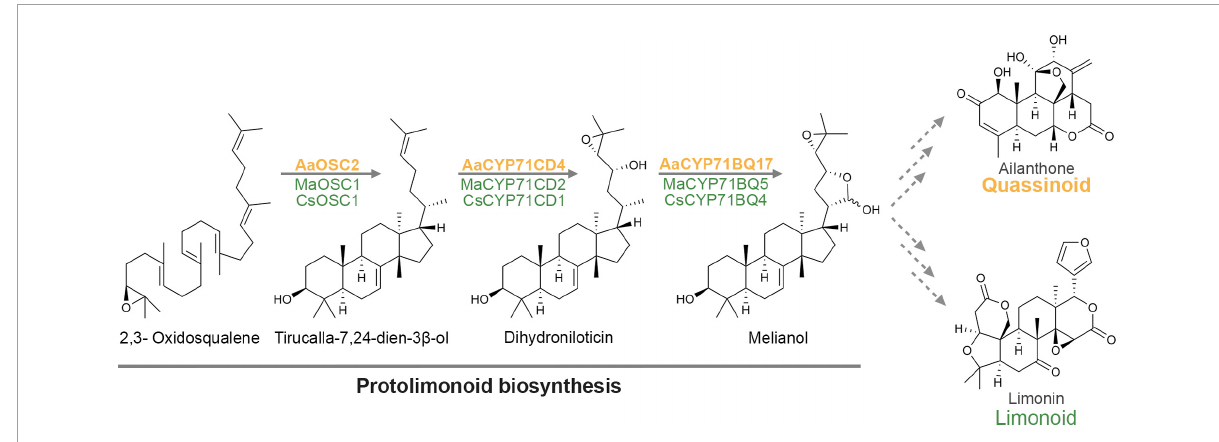
FIGURE5 Current model for quassinoid biosynthesis, highlighting the shared protolimonoid origin of quassinoids and limonoids up to